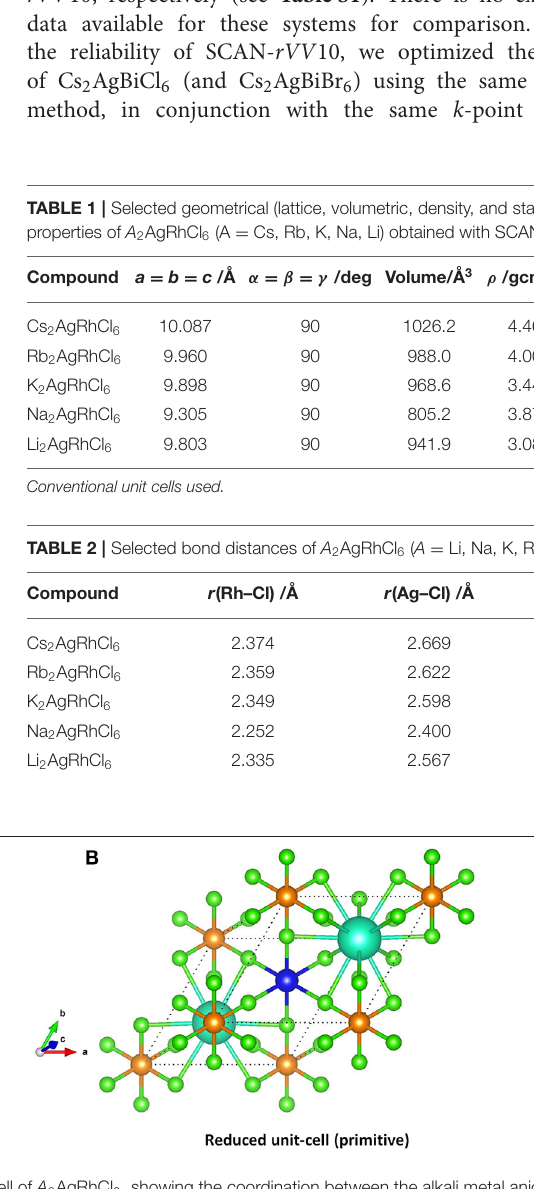
Frontiers in Chemistry |